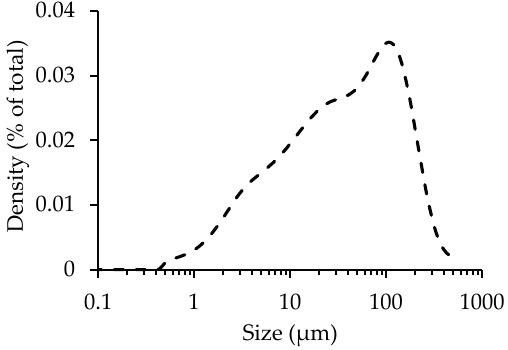
Figure 8. Particle size distribution of CPP before carbonation.